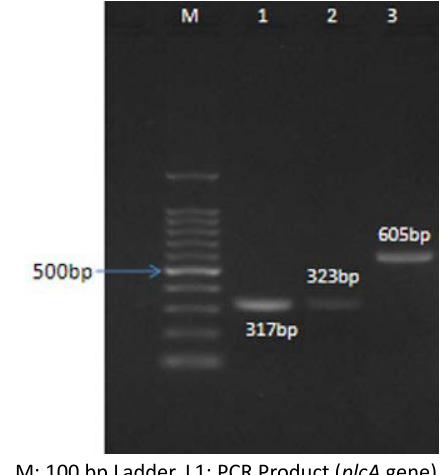
Fig.3. Identification of L.monocytogenes serotypes Fig.4. Virulent gene detection in L.monocytogenes